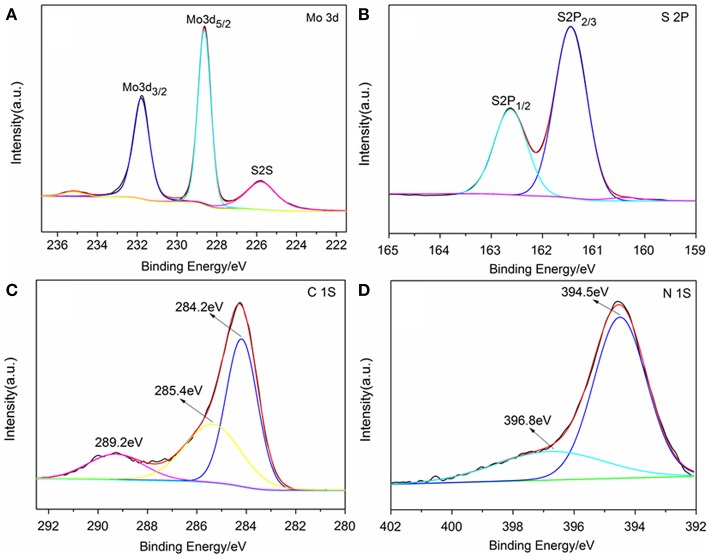
XPS spectrum of TNCT@MoS2. Mo 3d spectrum (A), S 2p spectrum (B), C 1s spectrum (C), and N 1S spectrum (D).